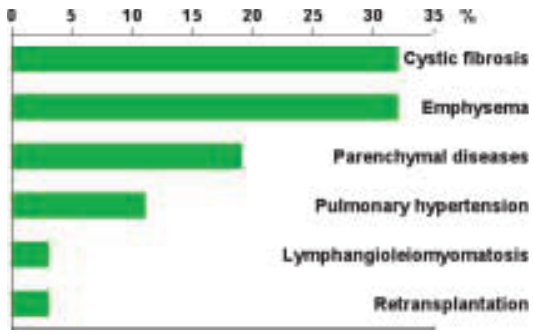
Distribution of the main diagnostic groups.